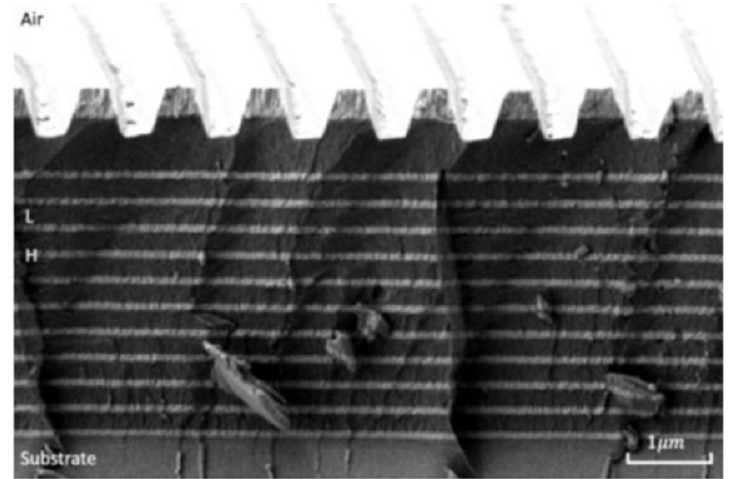
Figure 19. SEM image of a grating cross ‐ section.